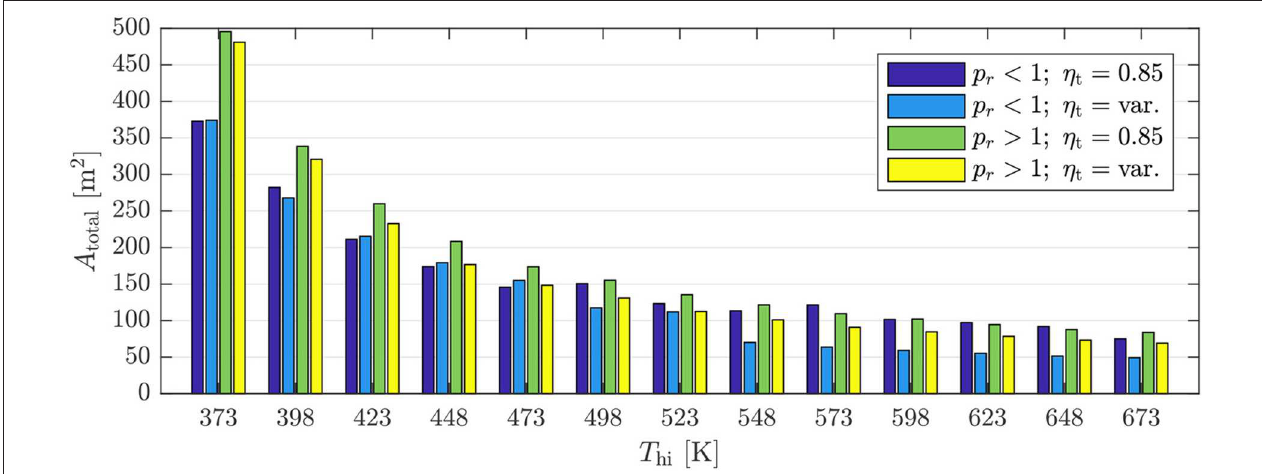
FIGURE 9 | Total heat-transfer area required for the optimal subcritical ( p r < 1) and transcritical ( p r > 1) cycles for different heat-source temperatures obtained using a fixed turbine efficiency ( η t = 0.85) and the variable efficiency model ( η t =